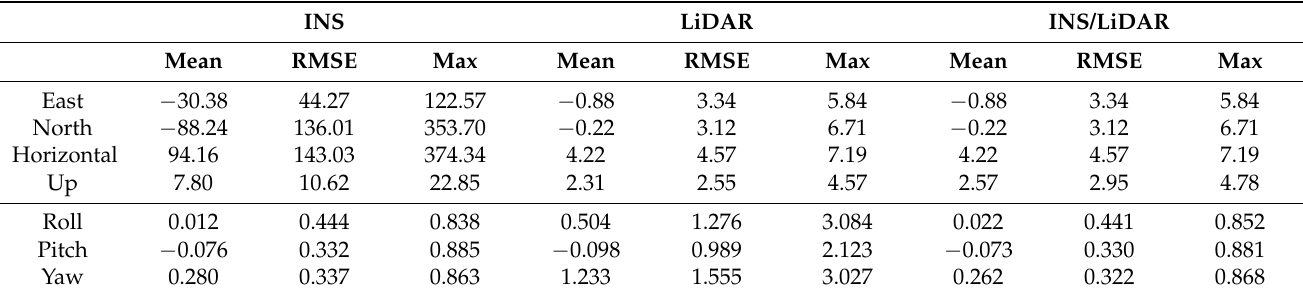
Table 2. D-27—position (m) and attitude (deg) error statistics.